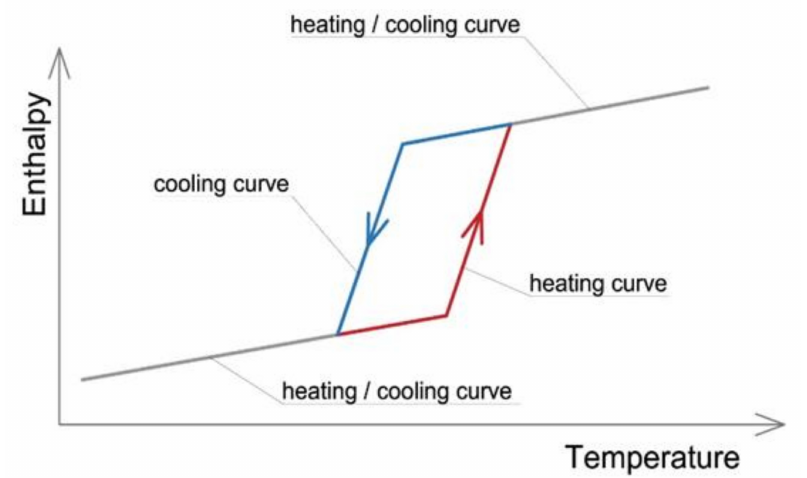
Figure 1. Phase change hysteresis process represented as a function of temperature.